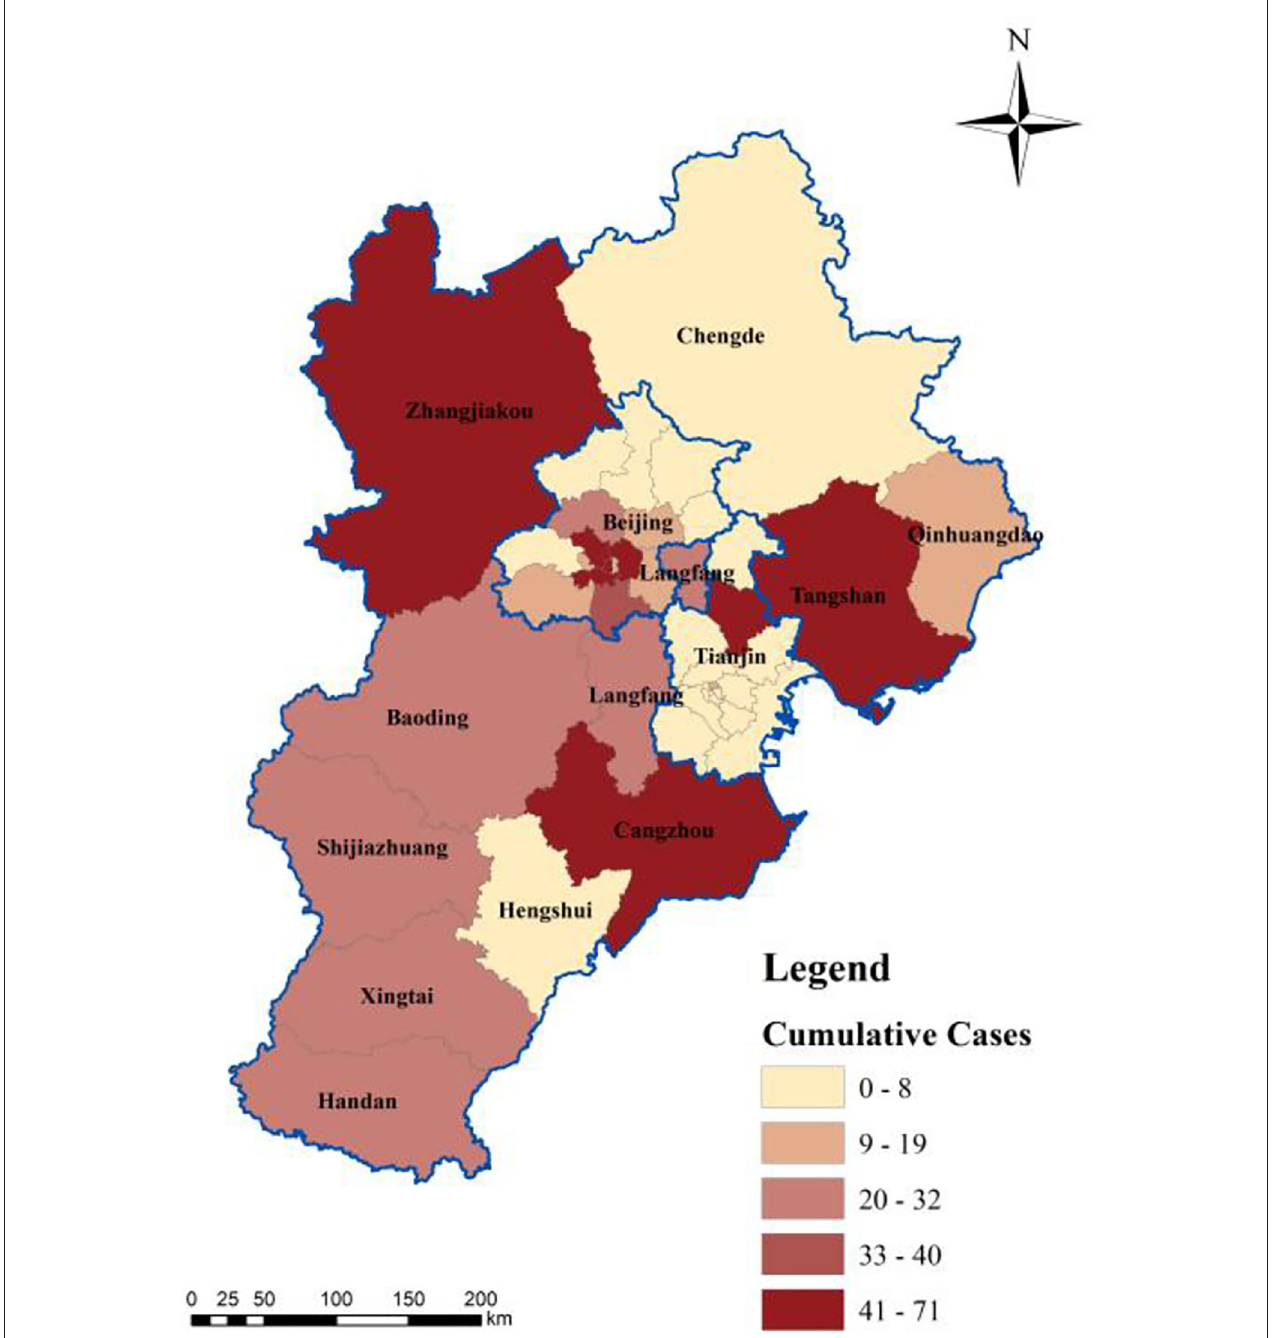
FIGURE 4 | Spatial distribution of confirmed